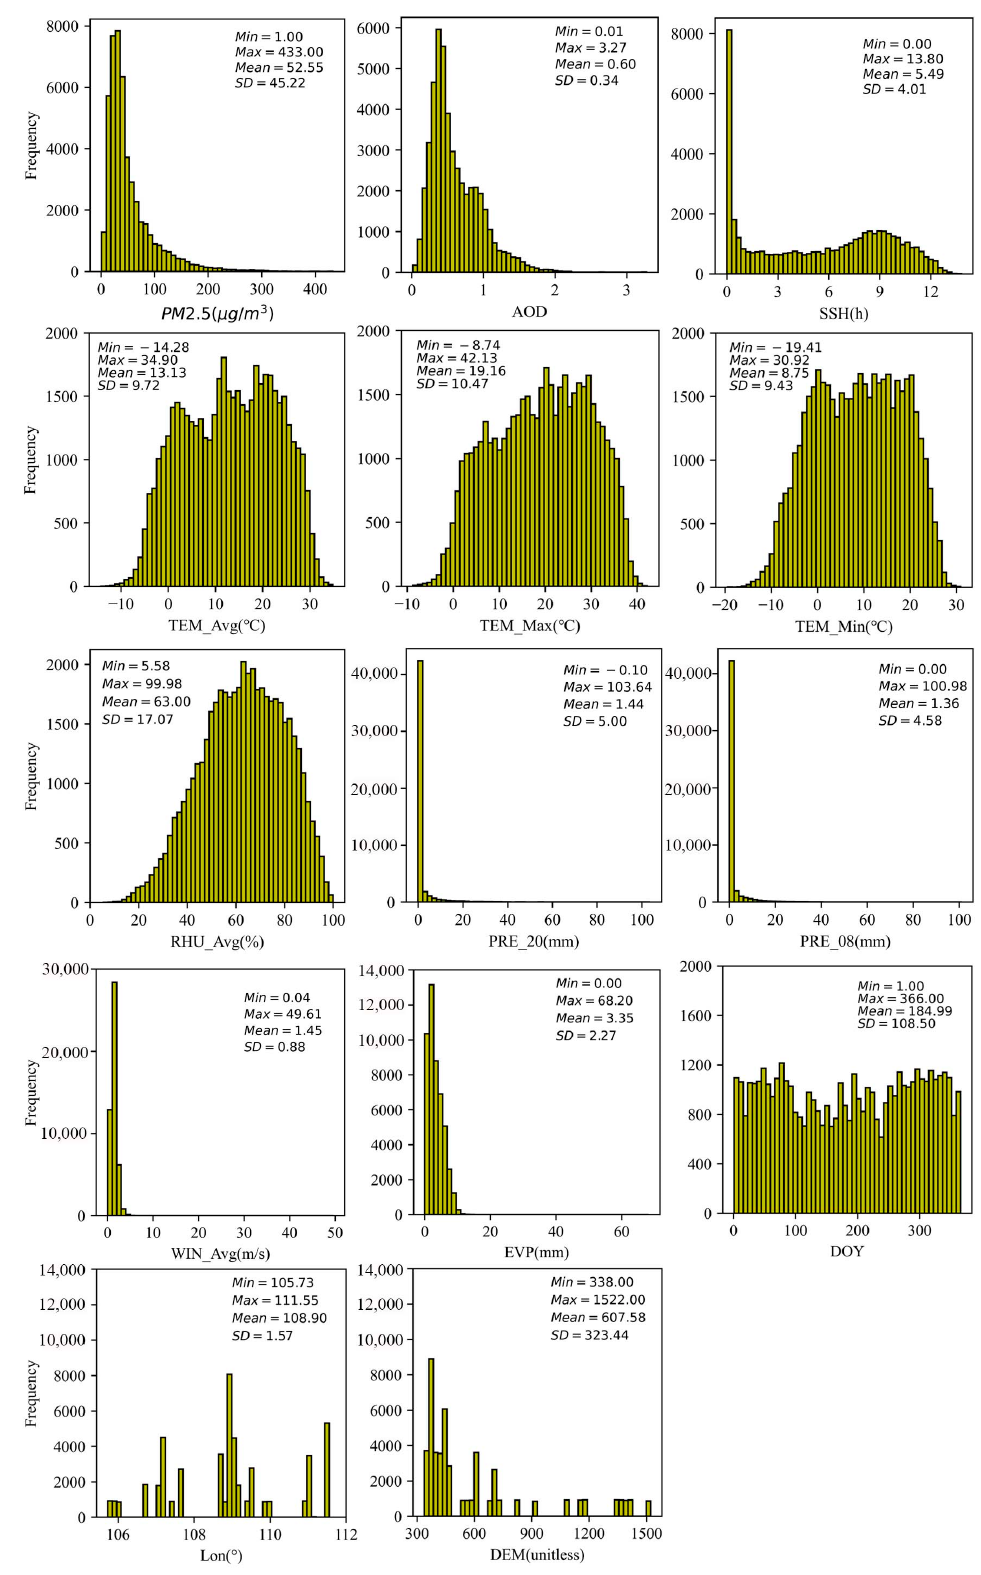
Figure 5. Histograms and descriptive statistics (minimum, maximum, mean, and standard deviation) for PM 2.5 and the independent variables used for modeling. Data are from 2018–2020 over GUA. The number of samples is 48,449.